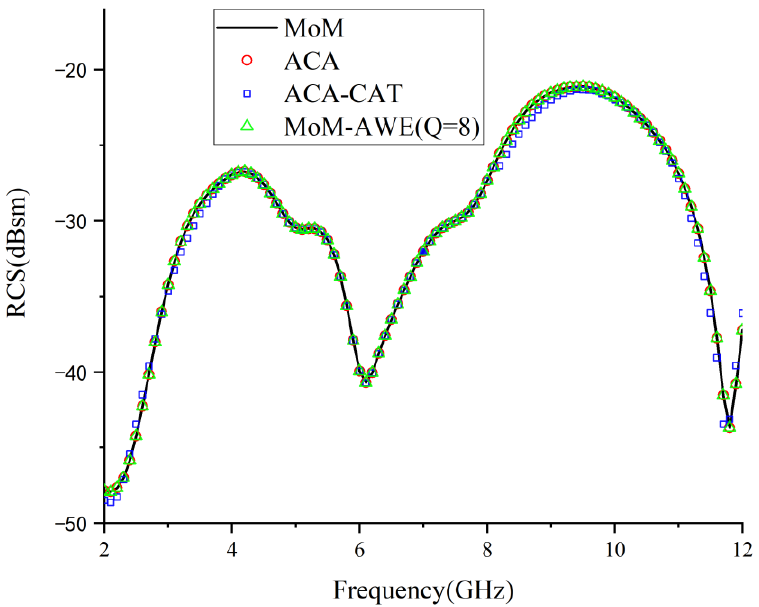
Figure 10. RCS with frequency for the four discrete objects by four different methods.